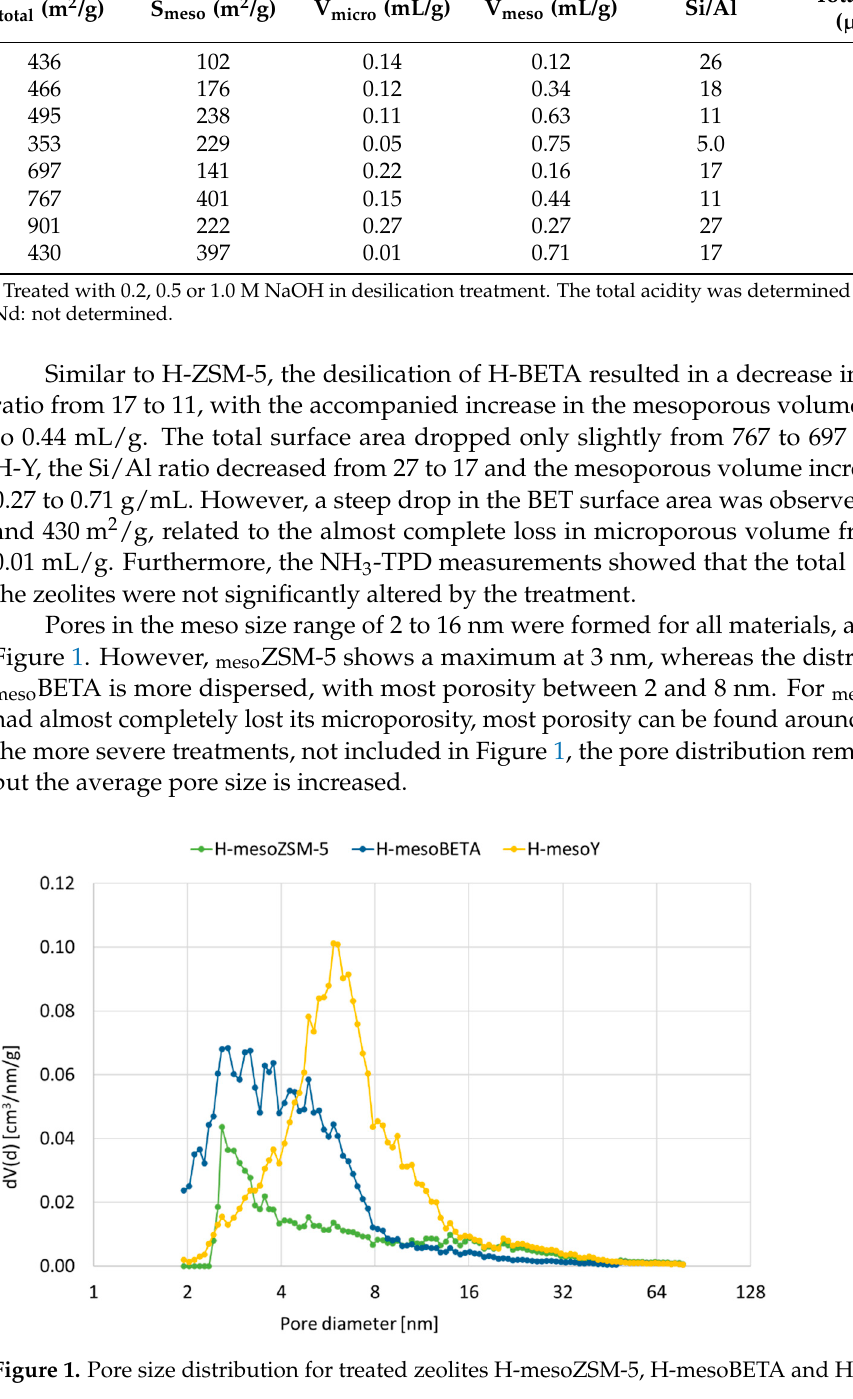
Table 1. Summary of zeolite properties used for the Co catalyst preparation.